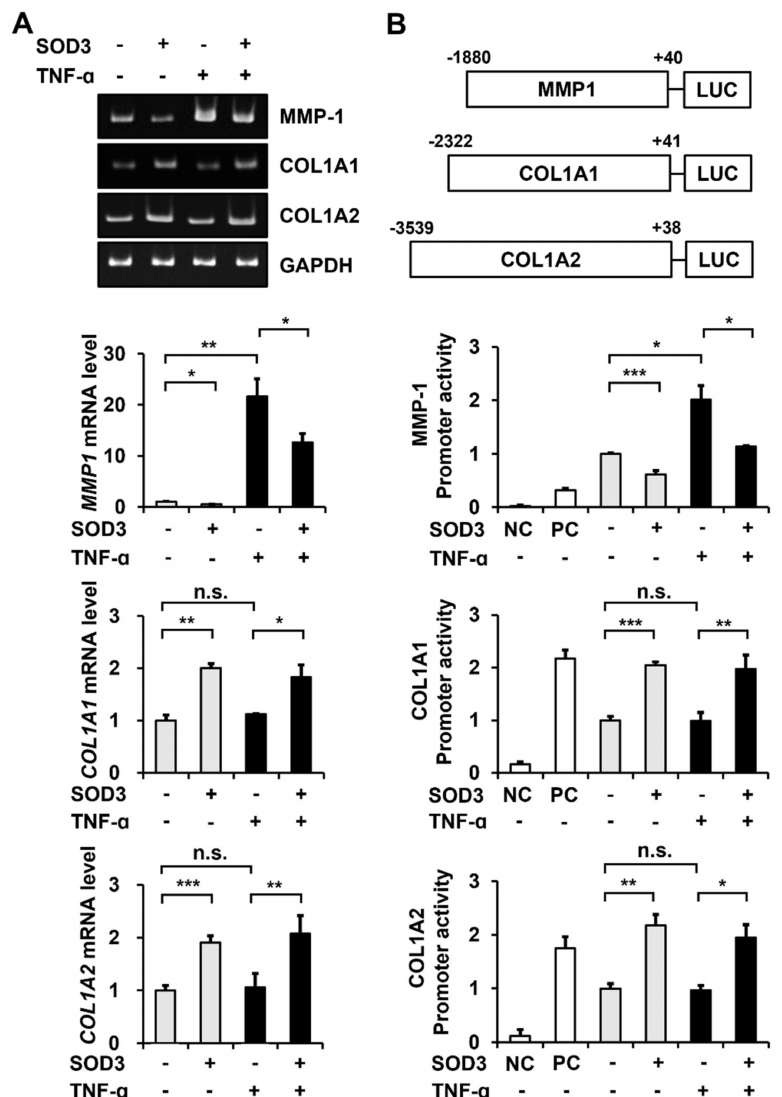
Figure 4. Effect of SOD3 on the transcription of MMP-1 and type I collagen genes in fibroblasts. ( A ) Human foreskin fibroblasts were incubated in a serum-free medium in the presence of TNF- α (1 ng/mL) and/or SOD3 (3 µ g/mL) for 24 h. Levels of MMP-1 , COL1A1 , and COL1A2 mRNAs